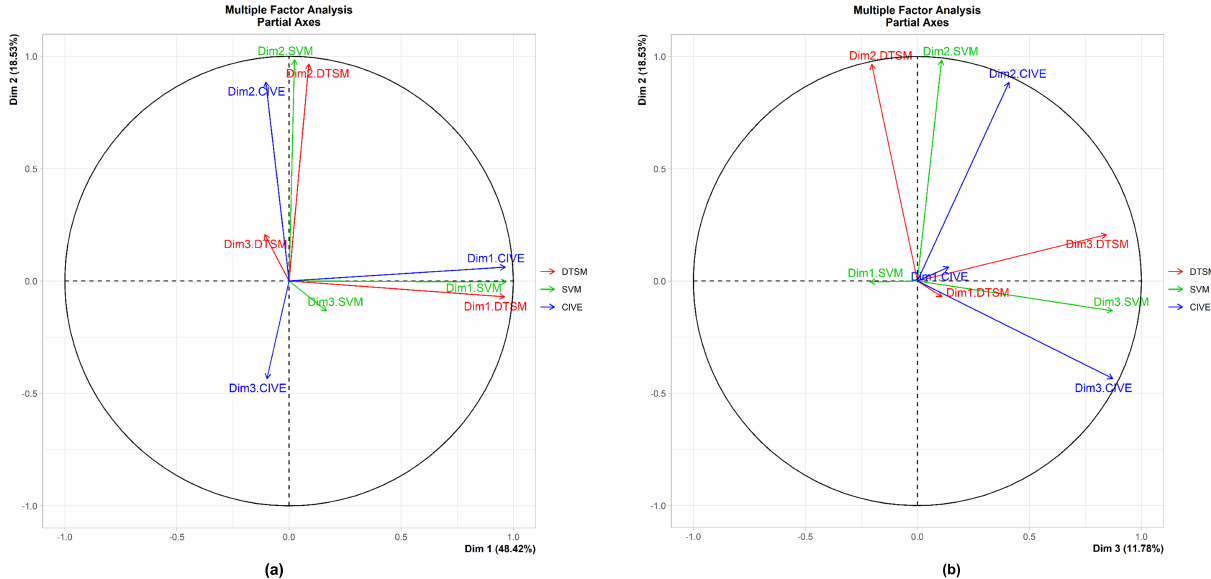
Figure 9. MFA partial axes’ plot: ( a ) 1st and 2nd dimensions; ( b ) 3rd and 2nd